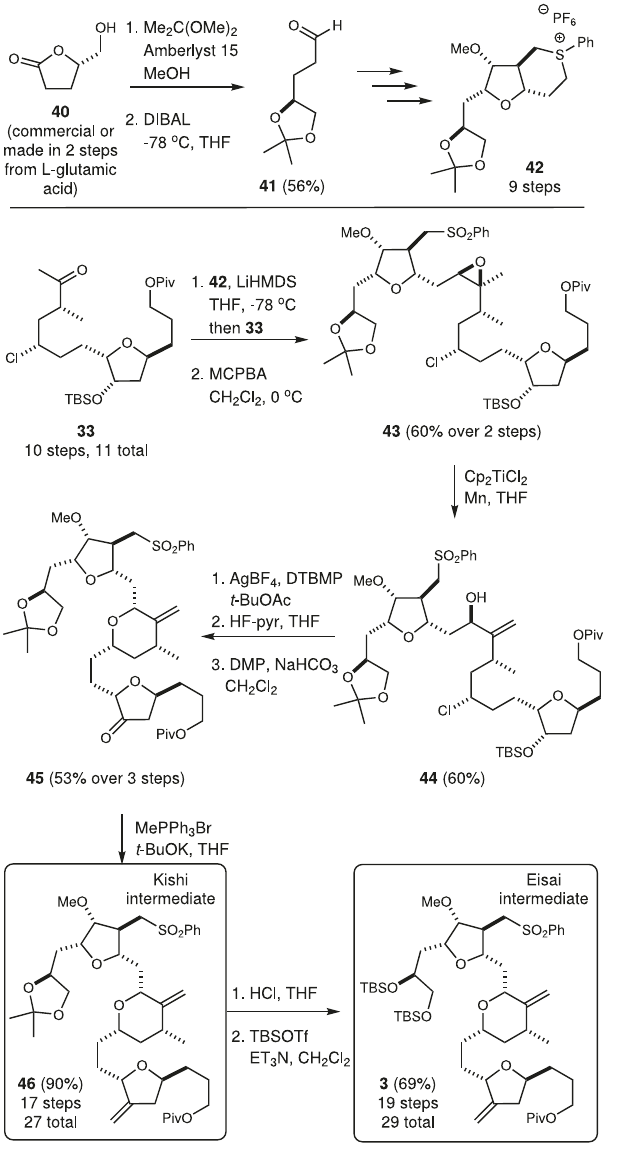
Fig. 5 | Synthesis of Kishi and Eisai intermediates 46 and 3. Exploiting the Corey – Chaykovsky coupling and Ti(III)-promoted rearrangement sequence, synthesis of the known acetonide- and TBS-protected diols 46 and 3 was accom- plished. Cp